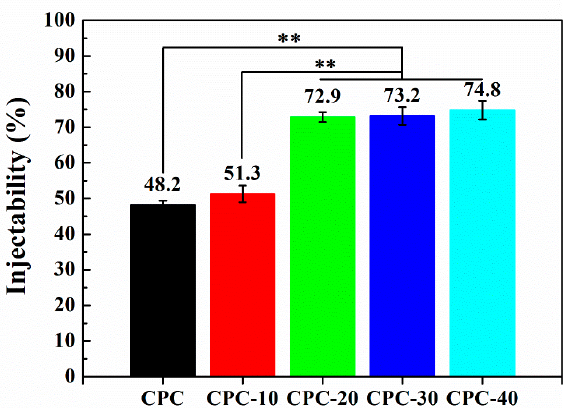
Figure 3. Injectability of CPCs containing di ff erent volume fractions of PLGA-PEG-PLGA hydrogel (n = 3, ** p < 0.001).